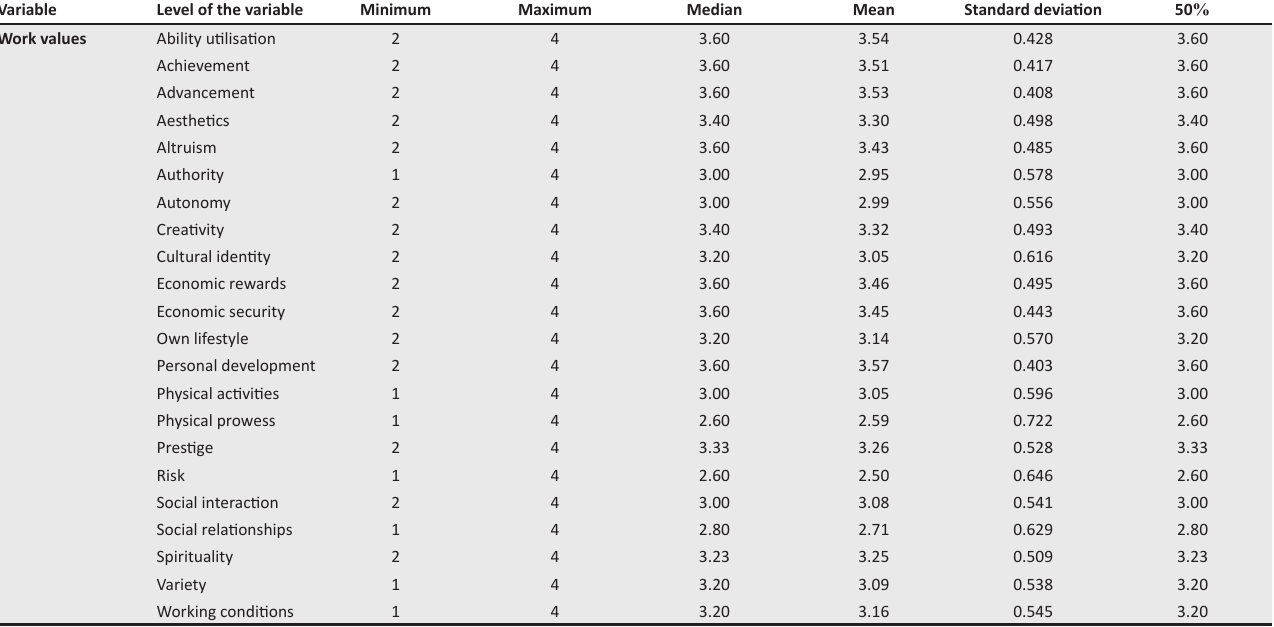
TABLE 2: Measures of central tendency for Generation X with regard to work values.